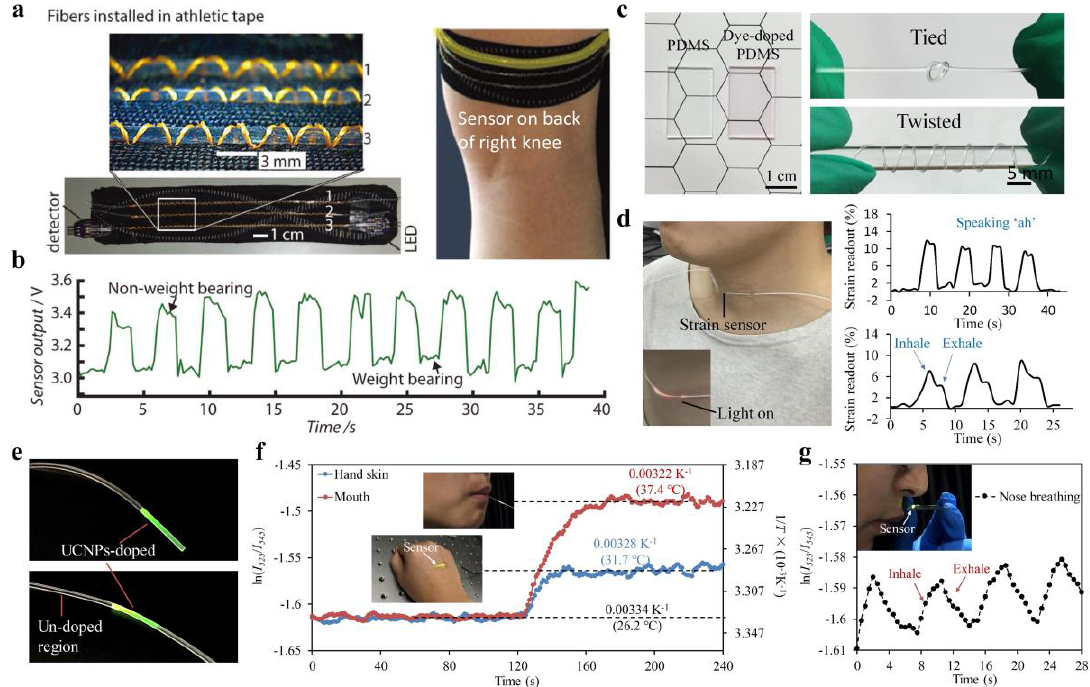
Figure 6. ( a , b ) Stretchable fiber-based strain sensor installed on an athletic tape to monitor weight-bearing activities. Reproduced with permission [70]. Copyright 2017, Wiley; ( c , d ) Dye-doped PDMS fiber developed for wearable strain sensing during speaking and deep breathing. Reproduced with permission [83]. Copyright 2017, Optical Society of America; ( e ) Photographs of upconversion nanoparticles (UCNPs)-doped fibers under 980 nm excitation. Reproduced with permission [64]. Copyright 2019, Wiley; ( f , g ) Demonstration of the UCNPs-doped fibers in real-time temperature monitoring of surface skin and interior mouth ( f ), as well as thermal signals generated by nose breathing ( g ). Reproduced with permission [64]. Copyright 2019, Wiley.